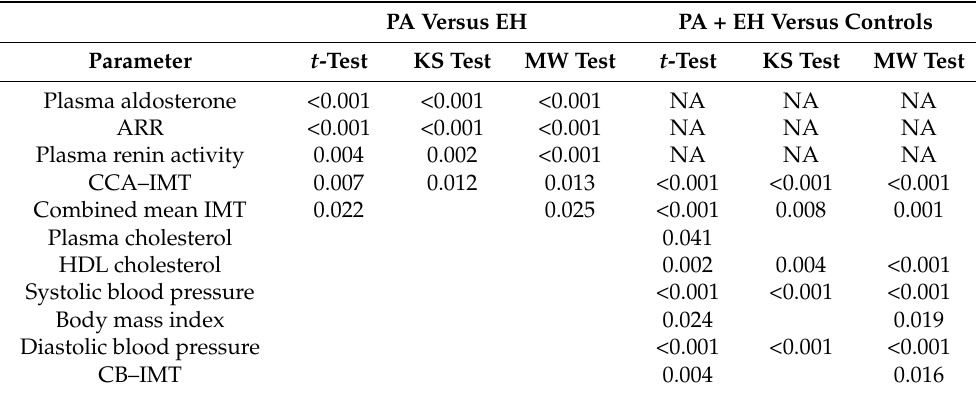
Table 4. A subset of clinical and IMT parameters significantly different between the PA and EH groups or between the PA + EH and control groups.